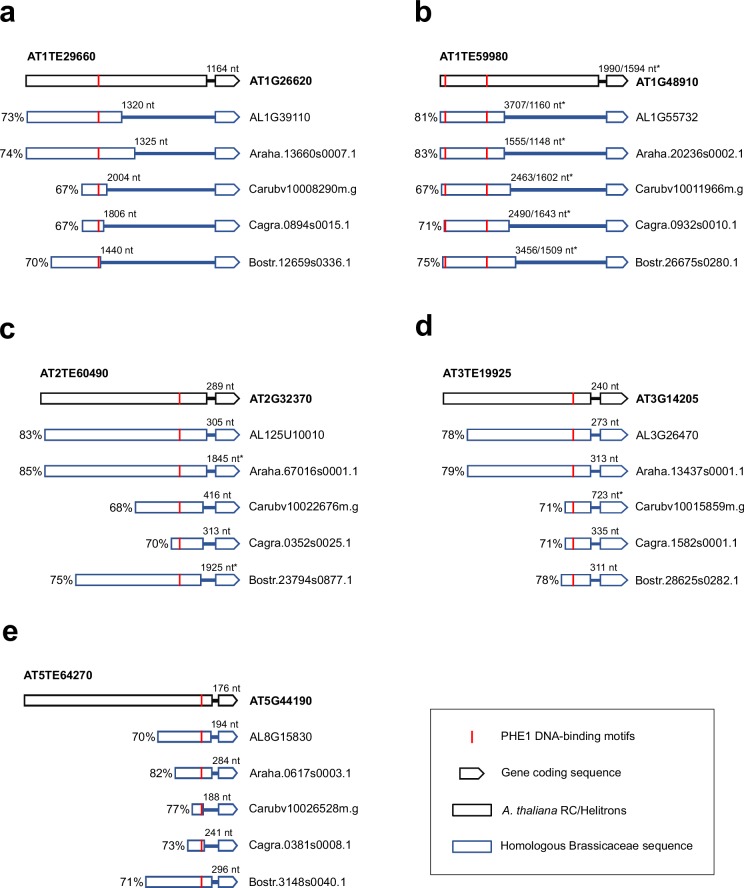
Analysis of PHE1-targeted PEG orthologs and upstream RC/Helitron sequences within Brassicaceae.Alignments between A. thaliana RC/Helitrons associated with PEGs (Figure 5a–e) and homologous sequences in other Brassicaceae, where the putative homologous PHE1 DNA-binding motifs are present across all six species. For each aligned fragment, the percent sequence identity is indicated. The distances between the binding motifs and the TSS of PEGs are labelled. *, the distance to the TSS, in cases where the annotation for the 5′-UTR of the gene is not available.